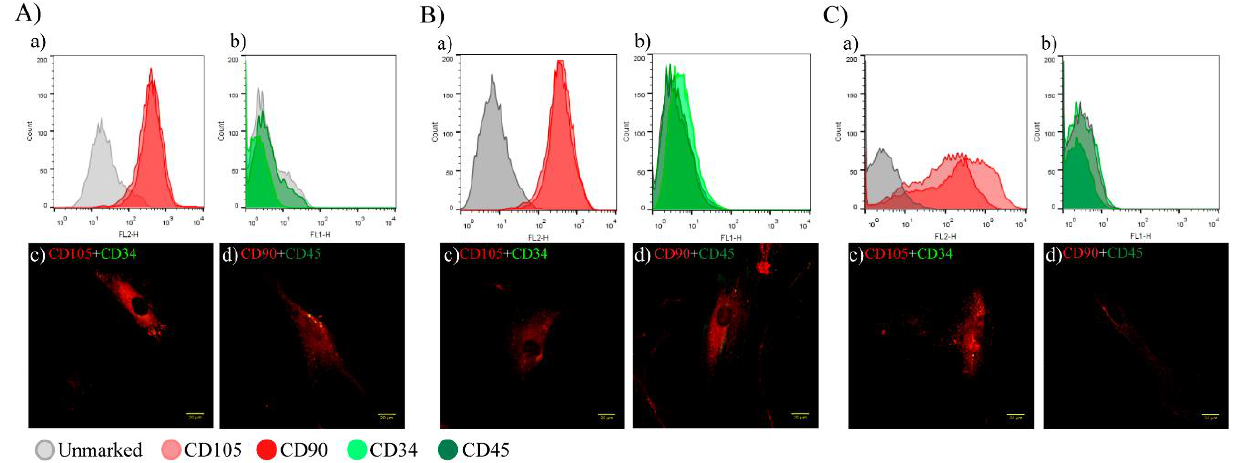
Figure 1. Characterization of hAT-MSCs. ( A – C ) Images of flow cytometry and fluorescence microscopy of CD markers specific to hAT-MSCs ( A = C0, B = C1, and C = C2). ( Aa , Ba , Ca ) CD105 and CD90 (positive in 70% of the cells). ( Ab , Bb , Cb ) CD34 and CD45 (unexpressed). The positive result was a peak fluorescence shift. These results were compared with C0 unstained (gray). Representative images of fluorescence microscopy, 40× objective: ( Ac , Bc , Cc ) Merged CD105 (red) and CD34 (green). ( Ad , Bd , Cd) Merged CD90 (red) and CD45 (green). n = 3; scale bars = 20 µm.